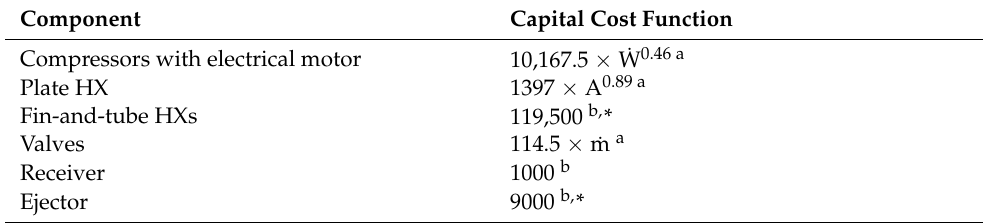
Table 4. Cost functions of various components